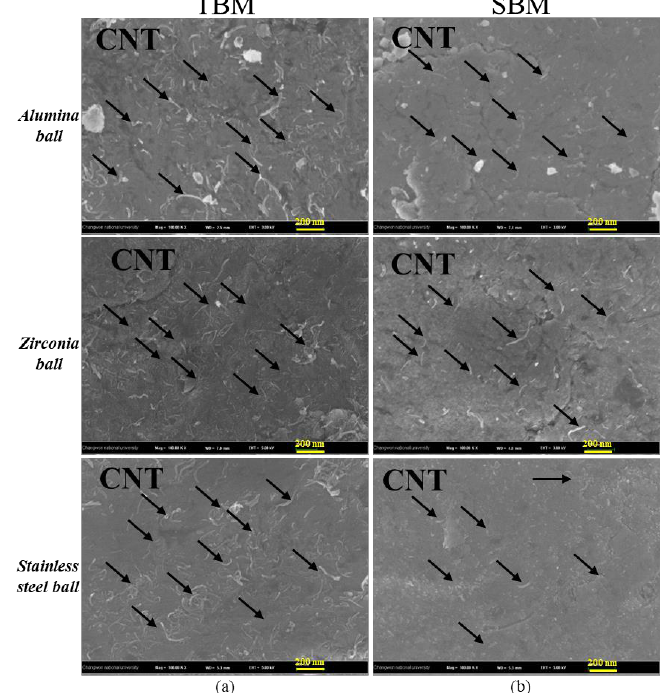
Figure 9. FESEM images (100,000×) of Cu/CNT nanocomposites for 48 h at 100 rpm in both mills ( a ) TBM and ( b ) SBM with three different milling media.